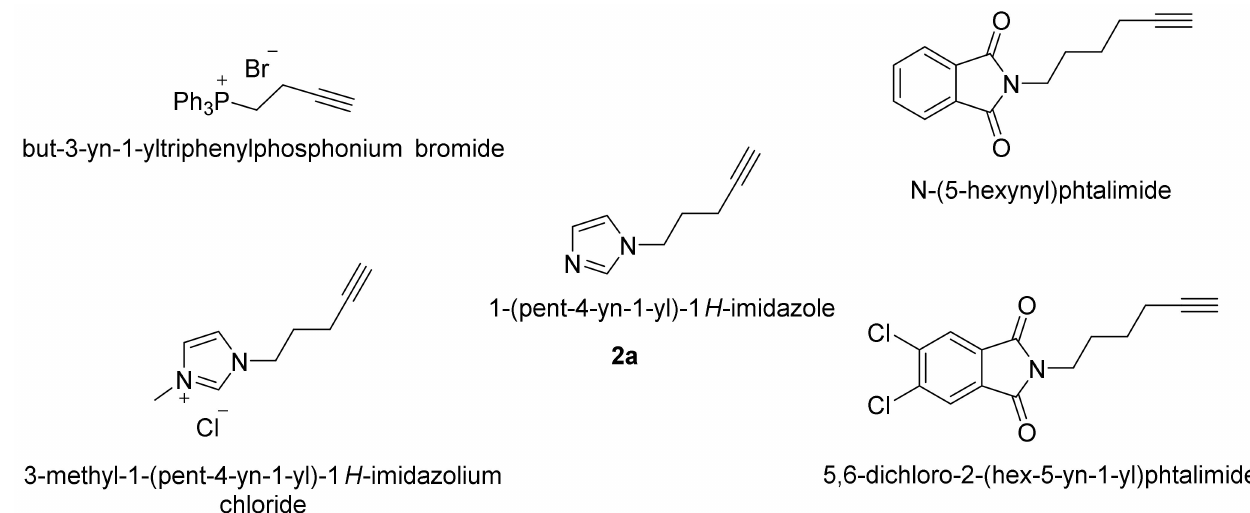
Figure 2. Selected alkynes tuned for ESI-MS detection used in this